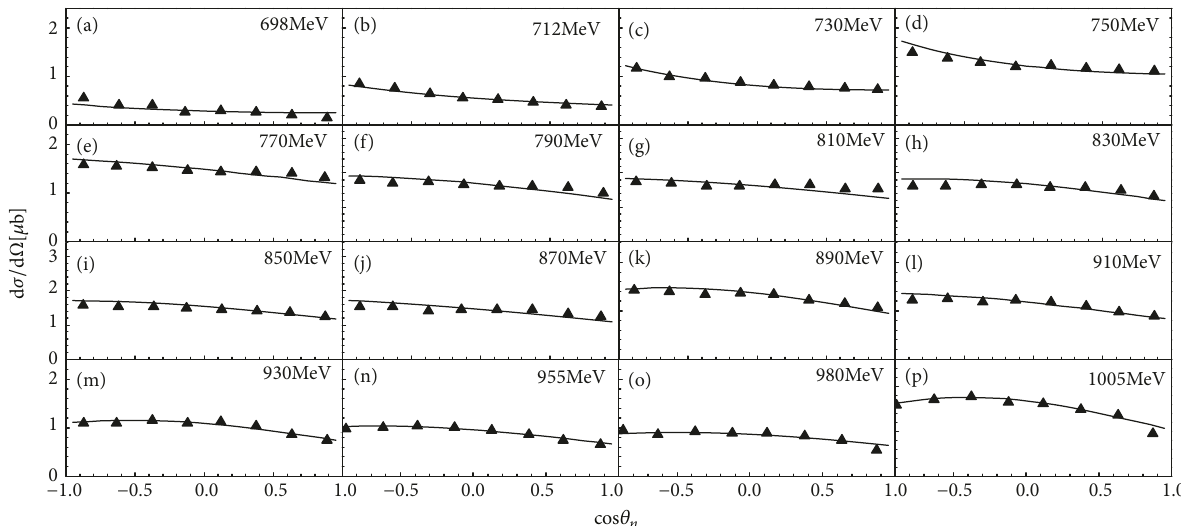
Figure 1: Angular distributions for different bins of incident photon energy 698 MeV ≤ E 𝛾 ≤ 1005MeV as a function of cos 𝜃 𝜂 in the beam- target cm system assuming the initial state nucleon at rest. The symbols represent the experimental data from the CBELSA/TAPS detector at the electron accelerator ELSA in Bonn [9]. The results in the multi-source thermal model are shown with the curves.